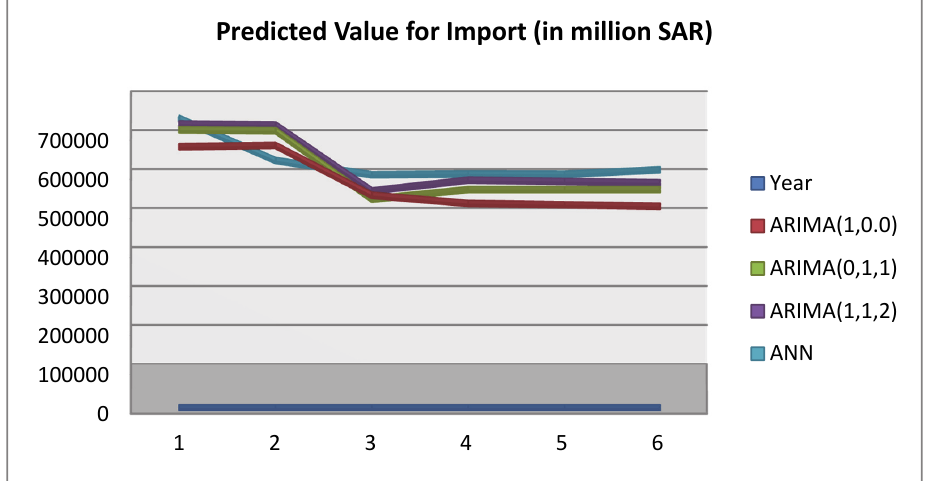
Fig. 11. Predicted Value for Export (in million SAR)